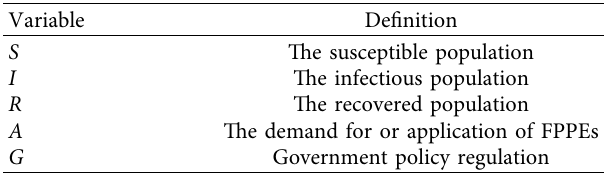
Table 1: Definition of model